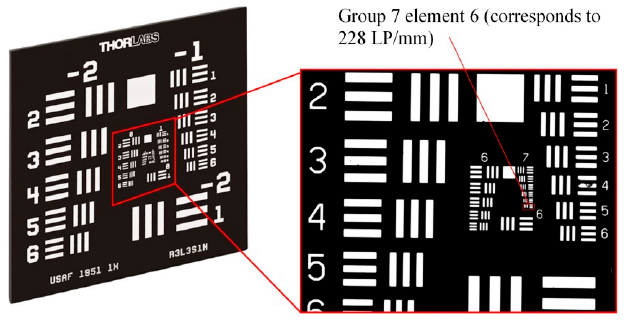
Figure. 5. The 1951USAF resolution target using for evaluated the microscopic imaging system. At the optimum focusing position, four wavelength LED light sources ( λ = 480, 550, 660, and 850 nm) were successively connected by an optical fiber to observe the effects of imaging the resolution target under illumination by different wavelengths, as shown in Figure 6. The minimum line pair position shown in Figure 6 is the group 7 element 6 pattern of 1951USAF resolution target, which corresponds to 228 line pairs per mm (LP/mm). It can be seen that under illumination by all four wavelengths, the microscope can clearly image the resolution target. The horizontal and vertical intensity profiles of the four images in group 7 element 5 and group 7 element 6 have been presented.